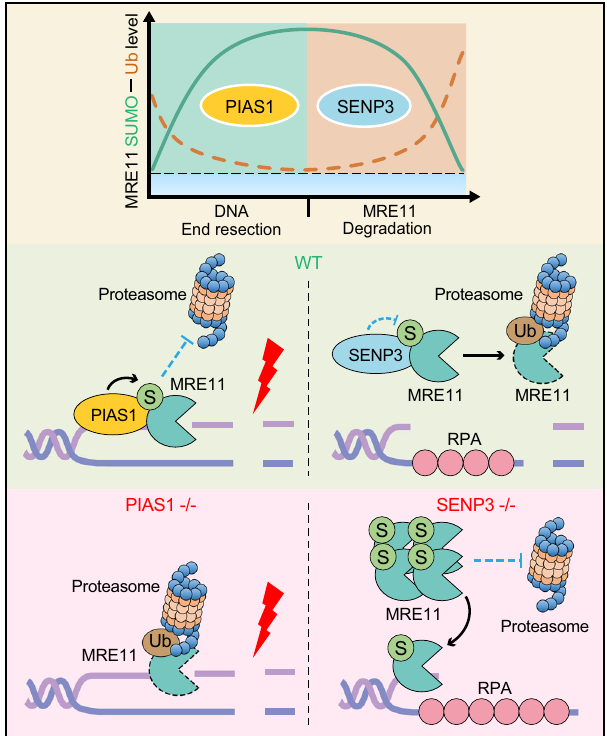
Fig.9|AworkingmodeloftheMRE11SUMOylationinDNAdamagerepair. The PIAS1-SENP3 axis dynamically controls the SUMOylation and ubiquitylation levels of MRE11 to facilitate DNAend resection. Upon DSB induction, the SUMO E3ligase PIAS1 and MRE11 are recruited to broken DNA ends, and MRE11 SUMOylation is enhanced to antagonize ubiquitin-mediated proteasomal degradation during DNA end resection. Mainly after DNA end resection, SENP3 deSUMOylates MRE11 and prevents the excessive accumulation of